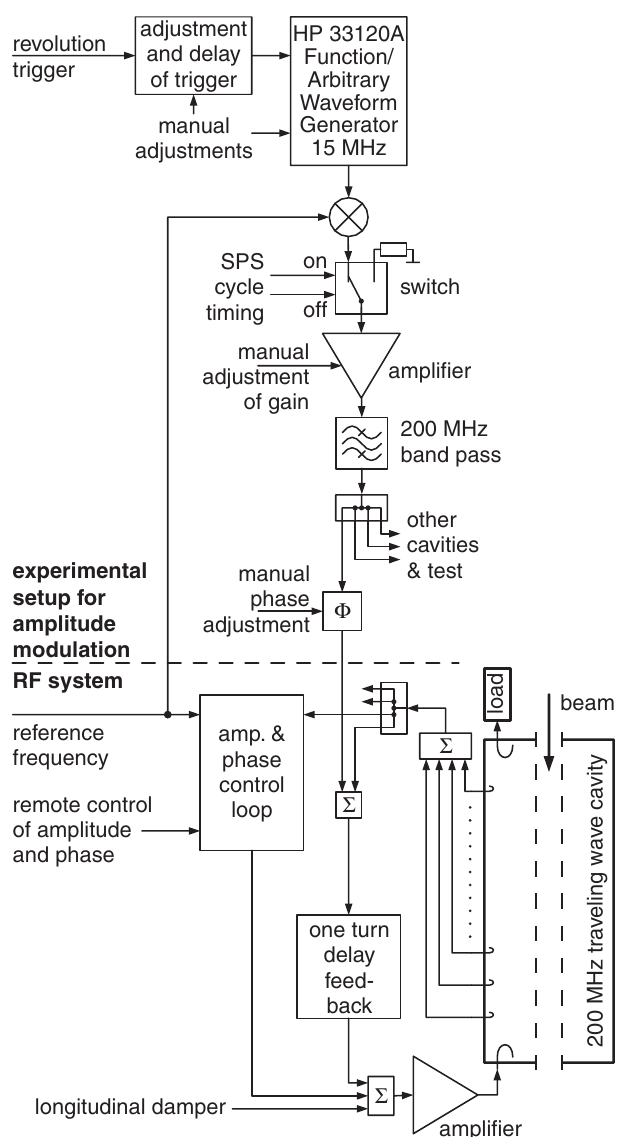
FIG. 3. Experimental setup for the rf amplitude modulation in the